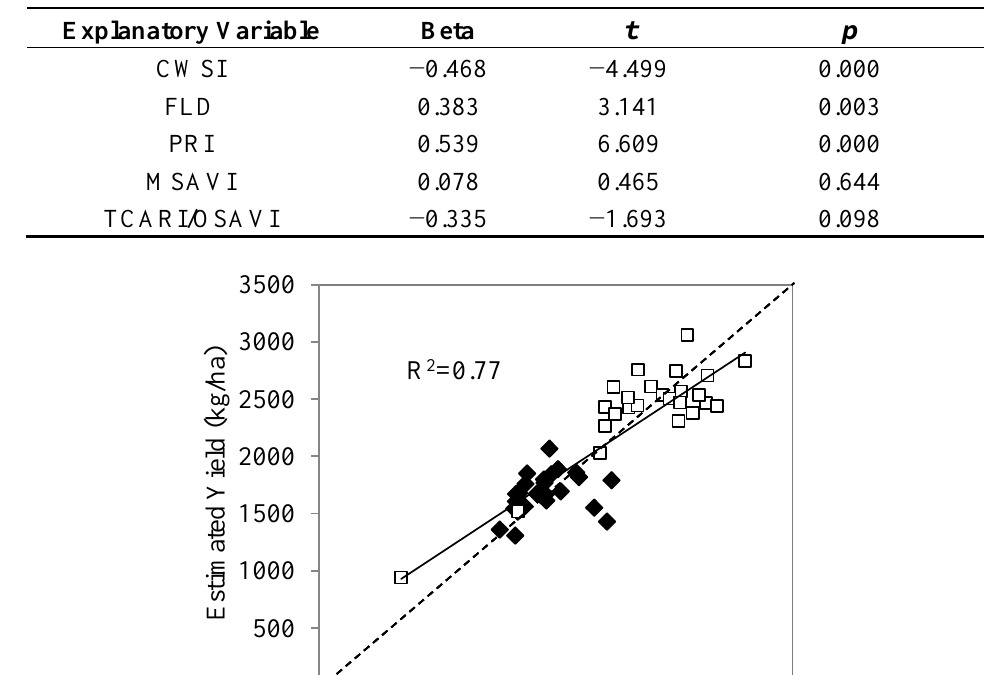
Table 3. Results of the multiple regression analysis performed on the selected indicators.